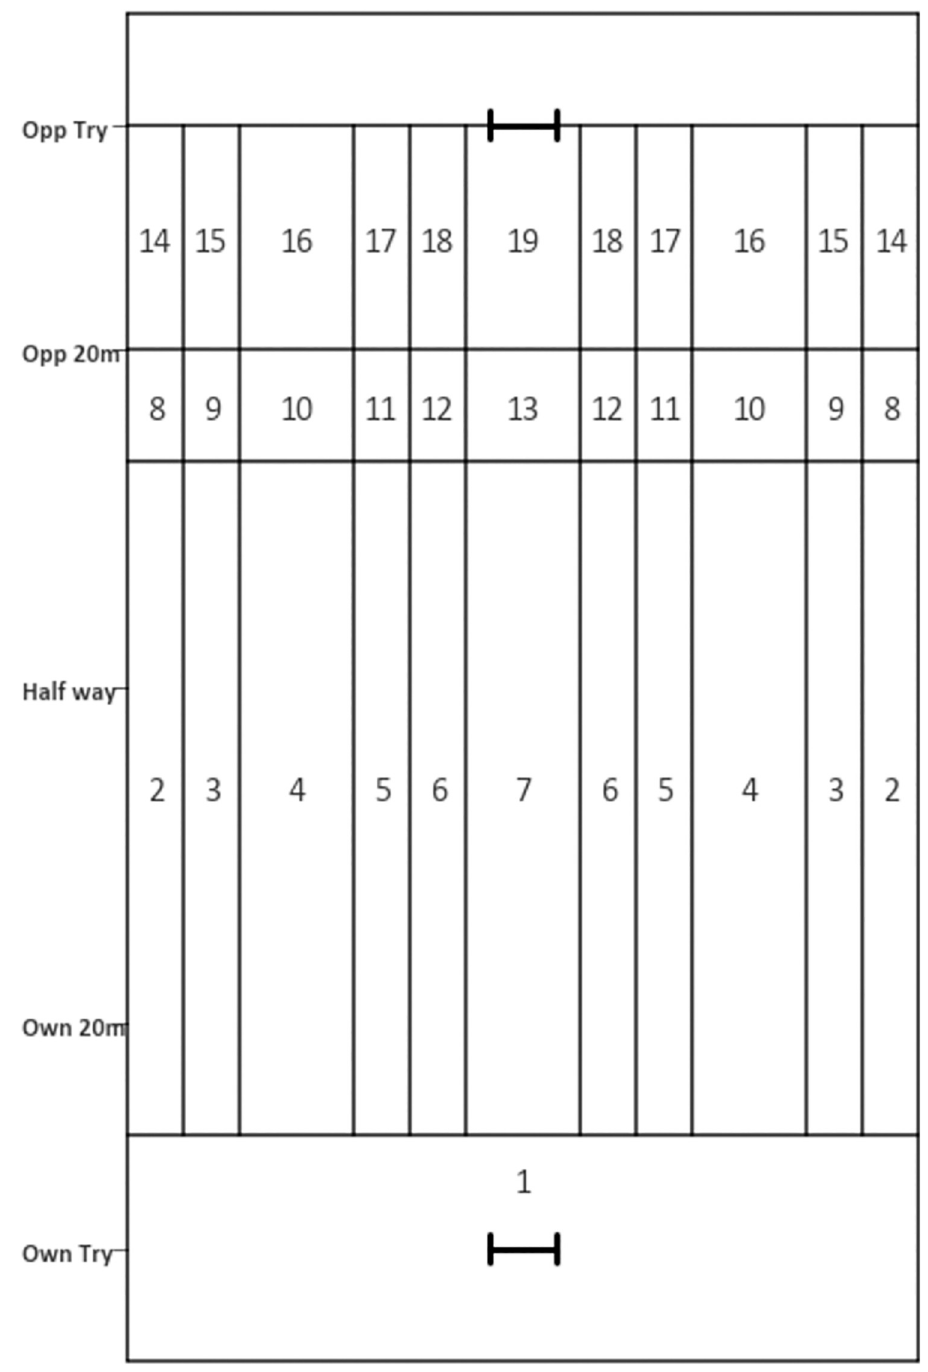
Fig 4. EPV-19 zones numbered so they can be distinguished from each other. Where numbers are repeated, both sides of the pitch make up the same zone (e.g. zone 2 is comprised of the widest ~5m on both sides of pitch, between 10m and 70m from the team’s own try